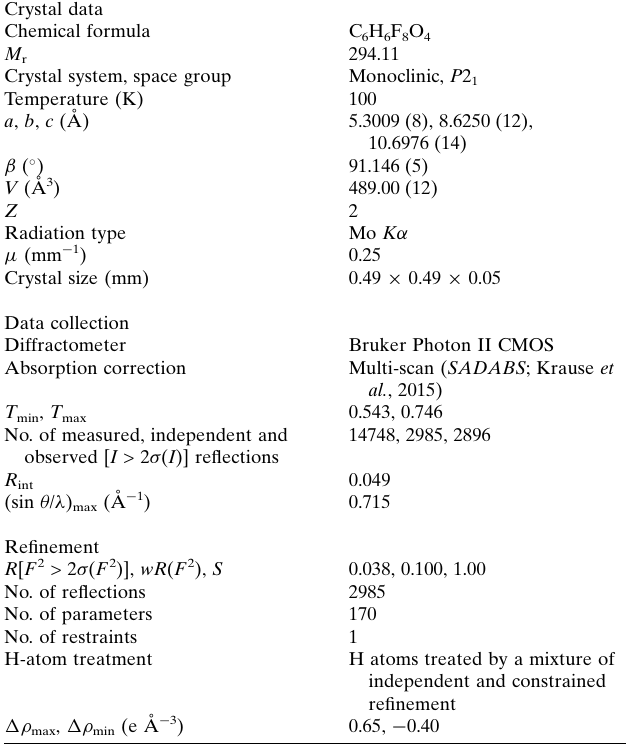
Figure 1 The molecular structure of the title compound. Displacement ellipsoids are shown at 50% probability